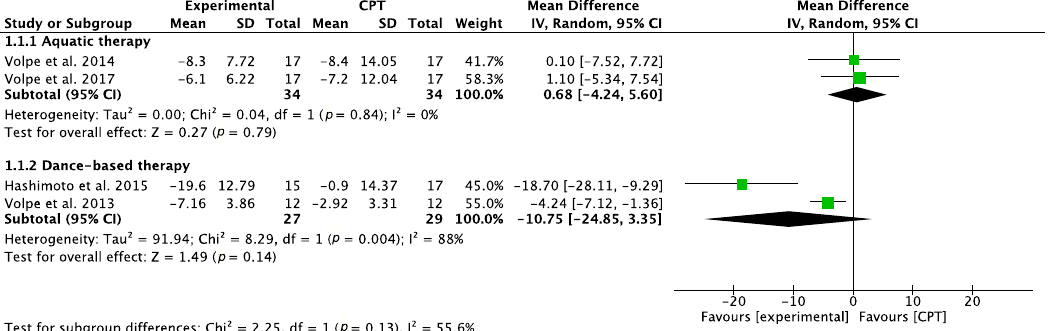
Figure 2. Forest plot for motor function measured by UPDRS-III. Green block indicates the weight assigned to the study and the horizontal line depicts the confidence interval. Black rhombus shows the overall result. The bold words highlight the total/subtotal values and the different modalities of therapies used in the